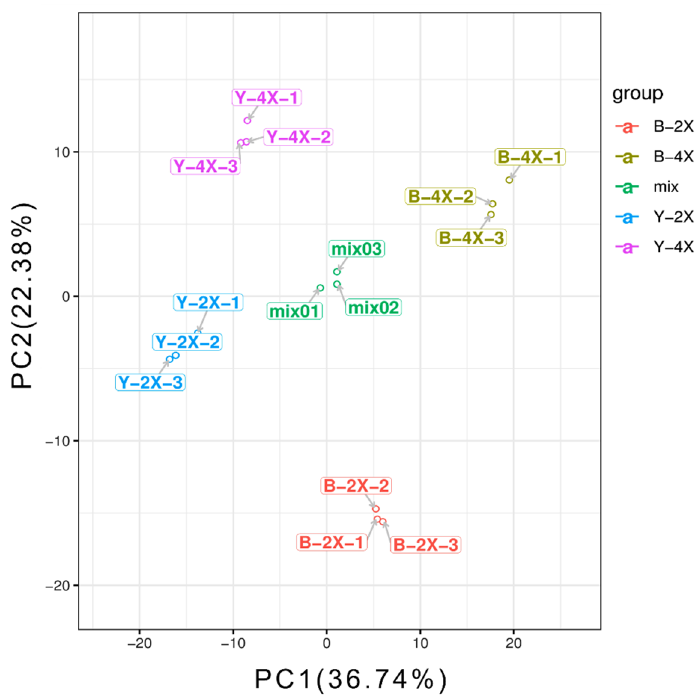
Figure 2. PCA scores plot map and hierarchical cluster analysis of diploid vs. tetraploid groups. (A) PCA scores plot for the diploid–tetraploid groups. B-2X: diploid Balilla, B-4X: tetraploid Balilla, Y-2X: diploid Yangdao 6, Y-4X: tetraploid Yangdao 6.